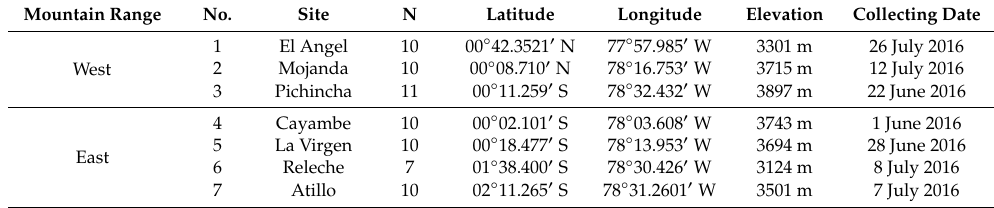
Table 1. Population and site information for each sample of Panabachia from p á ramo sites. Mountain Range